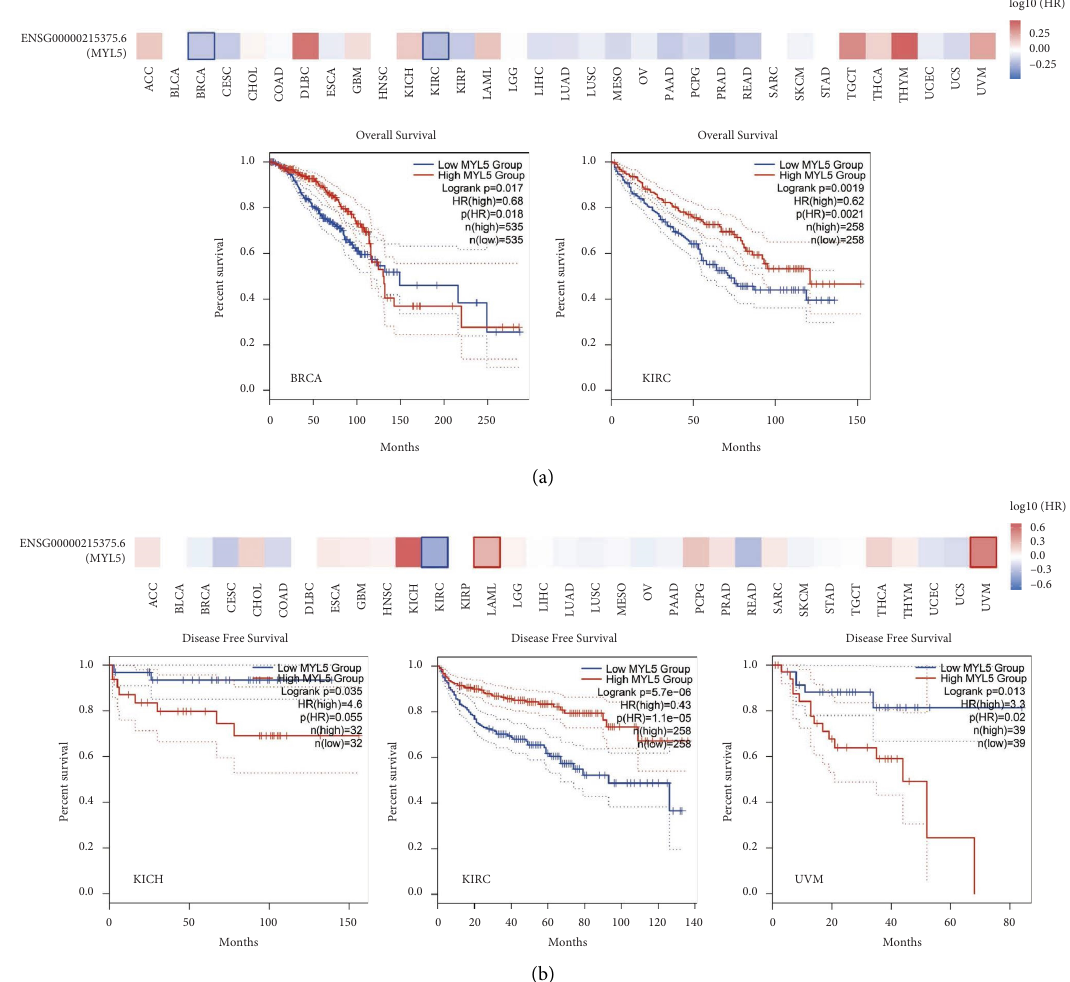
Figure 2: Te prognosis analysis of MYL5 expression in the TCGA dataset. Te efects of MYL5 expression on overall survival (a) and disease free survival (b) in diferent tumors were analyzed by using the GEPIA 2 tool. Te survival map and Kaplan–Meier curves with positive results were